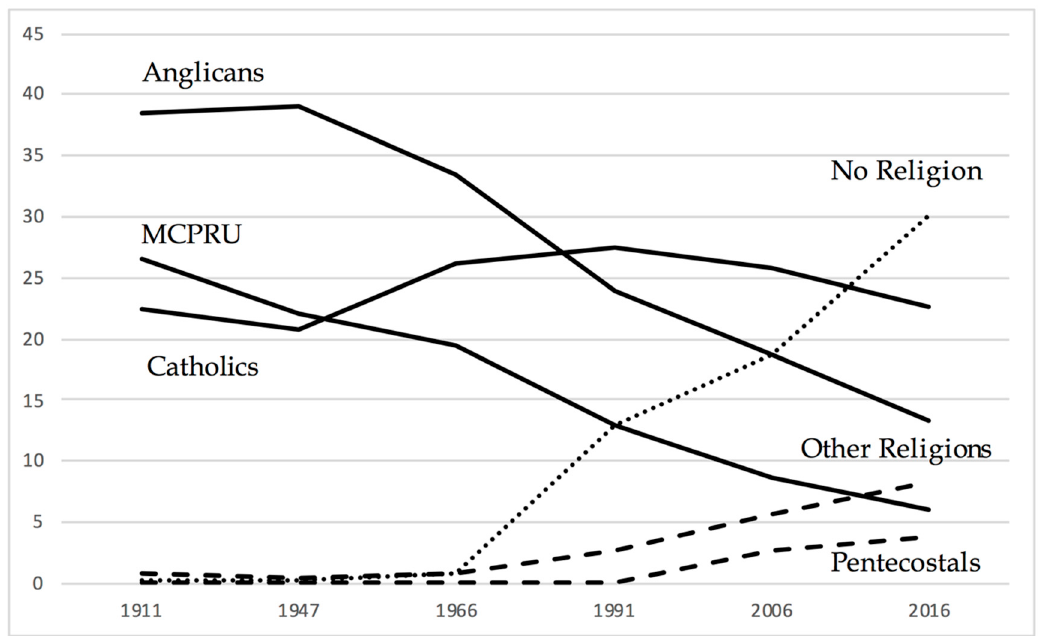
Figure 1. Key transitions in Australia’s religious demography. Source: Australian Bureau of Statistics (ABS) Census Reports compiled by Bouma (Bouma and Halafoff 2017a, p. 131). Note the X ‐ axis is not linear. MCPRU, Methodist, Congregational, Presbyterian, Reformed and Uniting. Pentecostal combines “Pentecostal and Christian nfd” (which includes most megachurches, such as Hillsong). Other religions, predominantly Buddhism, Islam, Hinduism, and Sikhism.